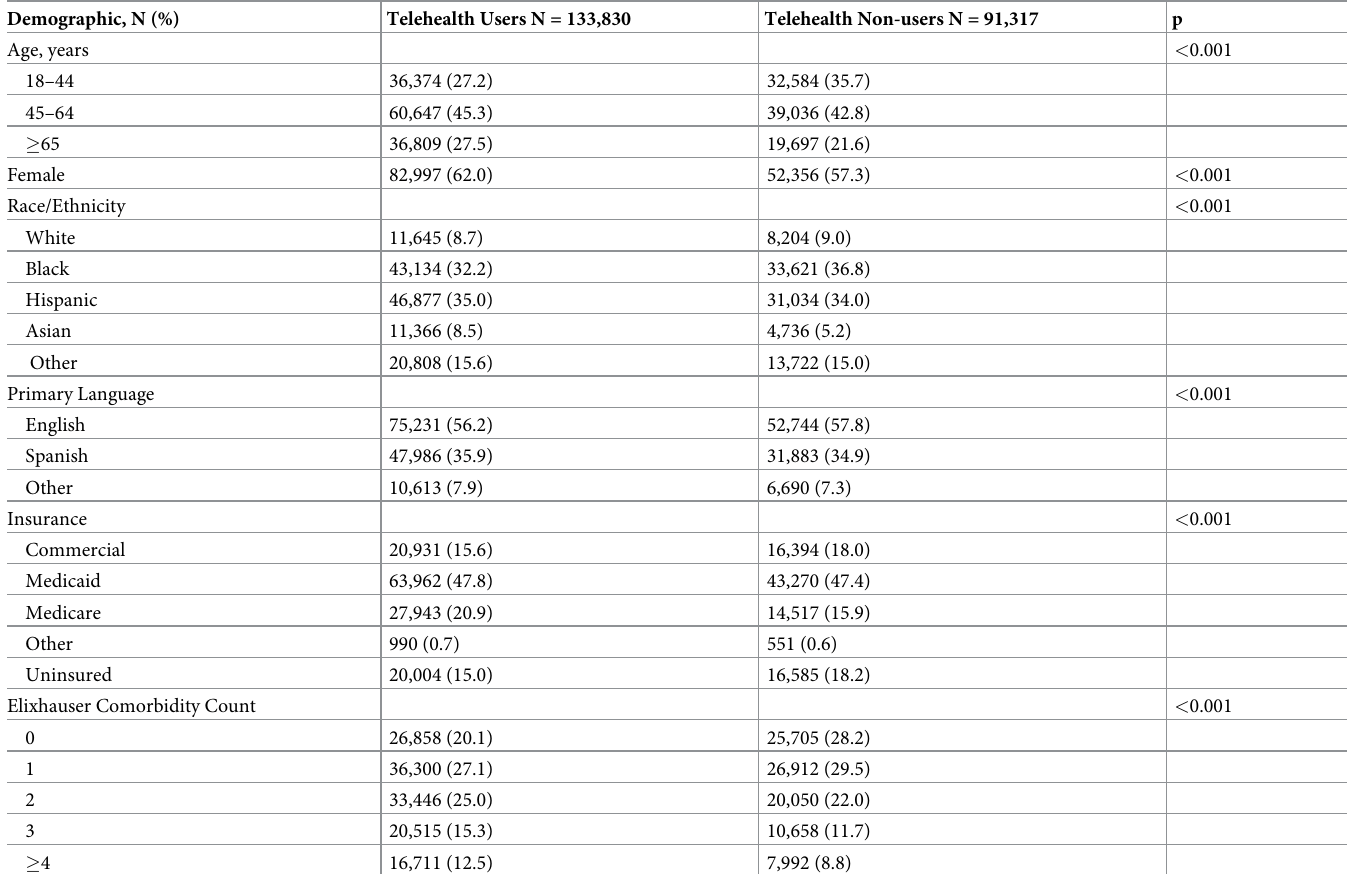
Table 1. Patient characteristics.